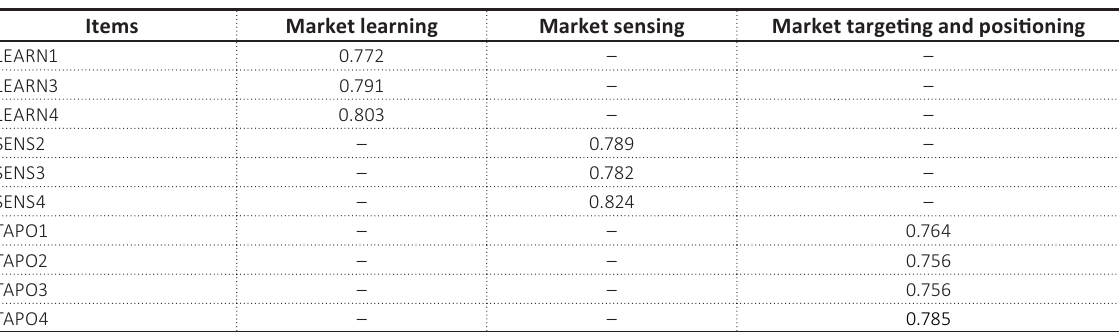
Table A2. Outer loadings